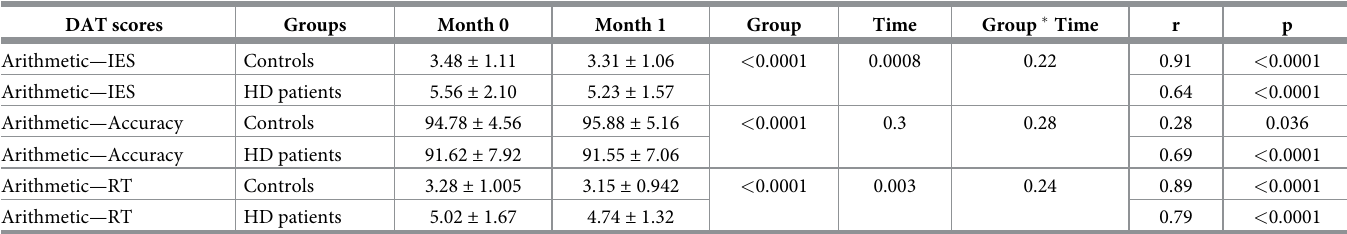
Table 2. Baseline and Month 1 comparisons on the